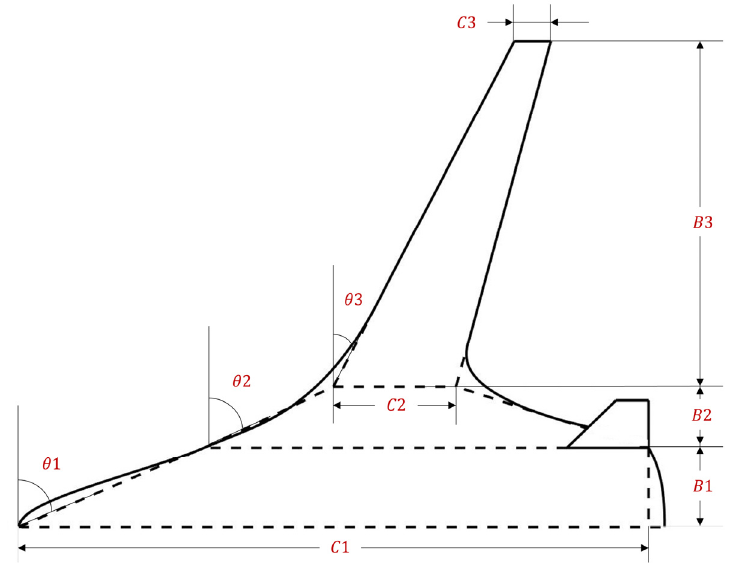
Figure 2. The planform parameters of HWB aircraft.